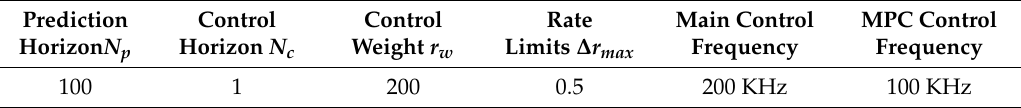
Figure 11. Comparative transient responses of PI 2 design of Table 3 with and without current-mode reference governor, with specs as in Table 4. ( a ) Startup transient response for tracking a reference input of 24 V with an input voltage Vin = 12 V; ( b ) reference input changes from 24 V to 20 V and back; ( c ) rejection of load step changes (from 10 to 50 Ω and back); ( d ) dealing with step changes in the input voltage (from 12 to 10 V and back). Table 4. MPC current-mode reference governor specifications.